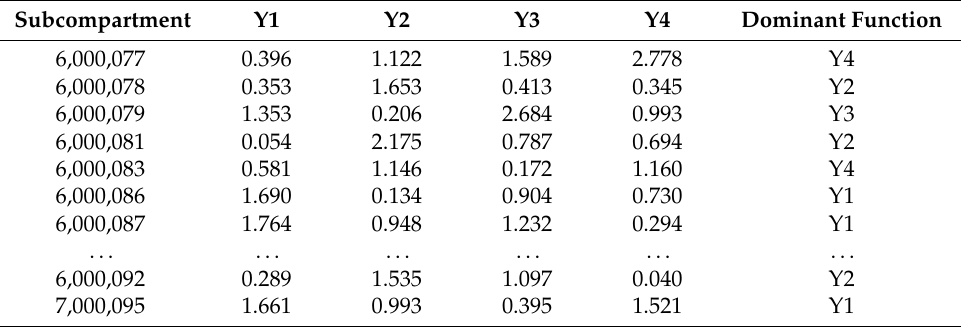
Table A3. Evaluation table of dominant function of subcompartment (Y1, Y2, Y3, and Y4 are the scores of wood production function, water conservation function, water and soil conservation function, and other functions,